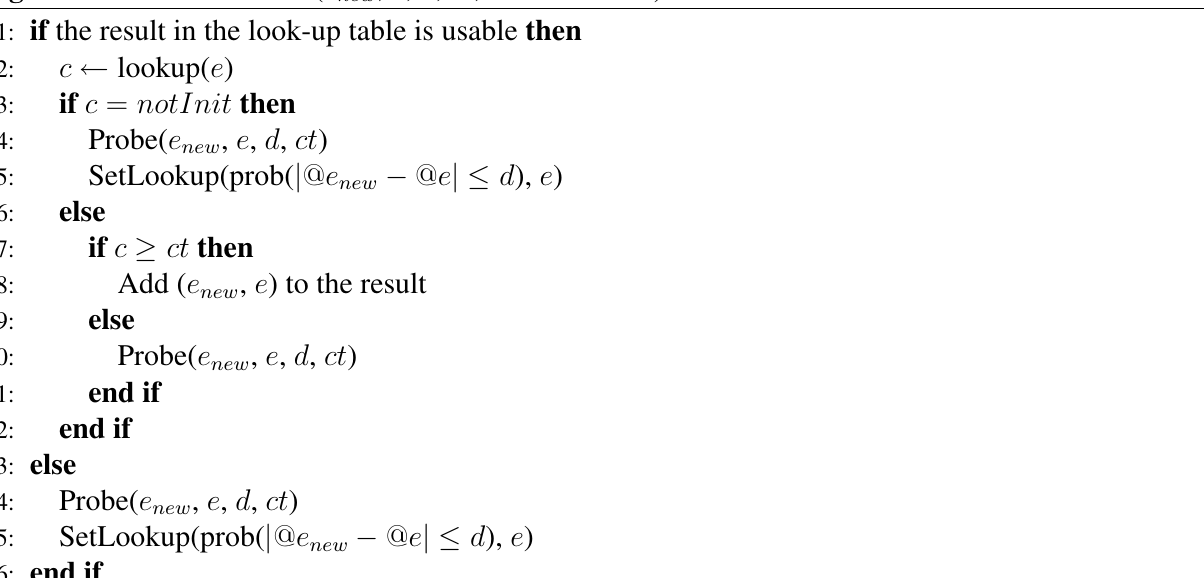
Algorithm 7 EfficientProbe( e